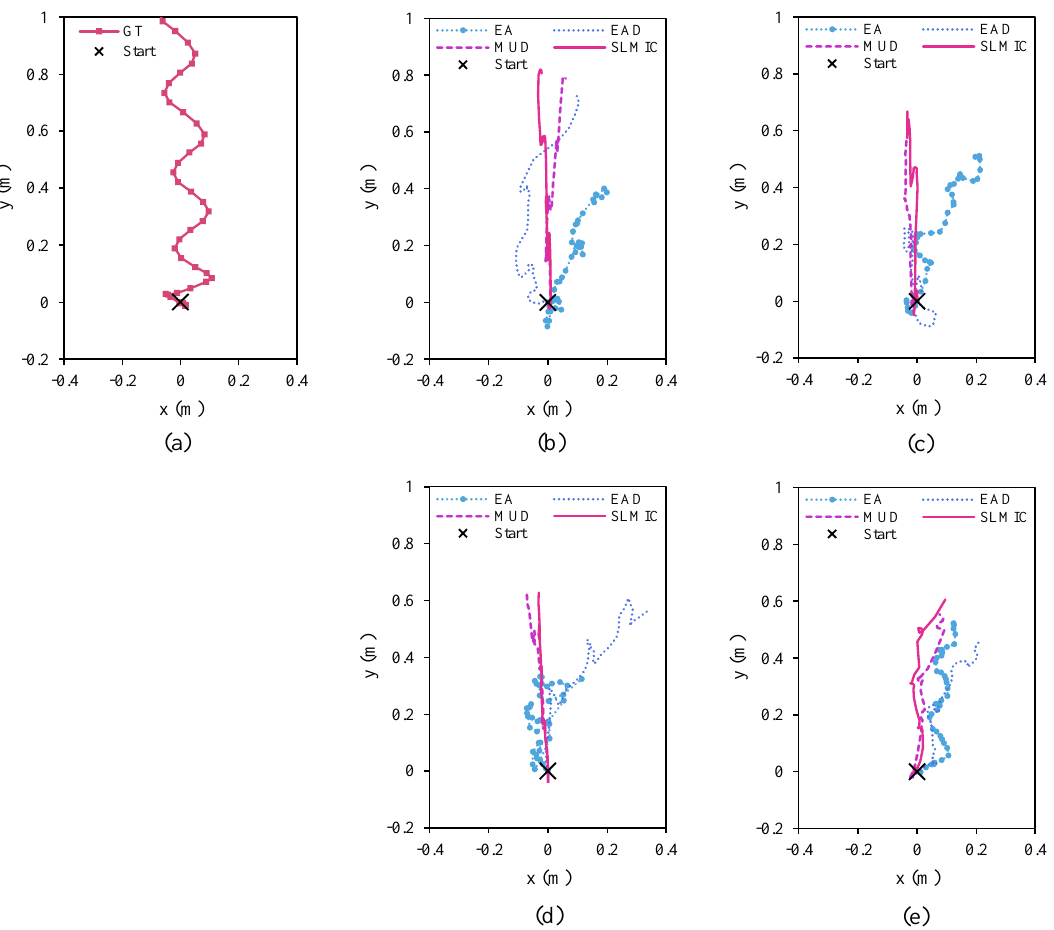
Figure 19. Comparison of simulation results obtained using EA, EAD, MUD and SLMIC: ( a ) ground truth of healthy robot walking with trotting gait; ( b ) one leg lost (case A); ( c ) two adjacent legs lost (case B); ( d ) two diagonal legs lost (case C); ( e ) two adjacent legs and one limb lost (case